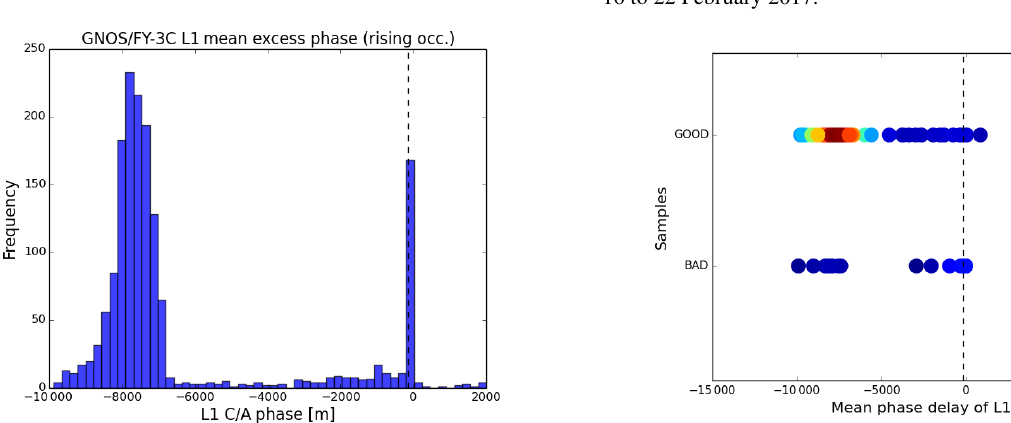
Figure 13. The L1 mean phase delay (m) versus the good and bad samples. Different colours represent different overlap densities, dark blue is the lowest and dark red is the highest, the colours be- tween them show gradually higher